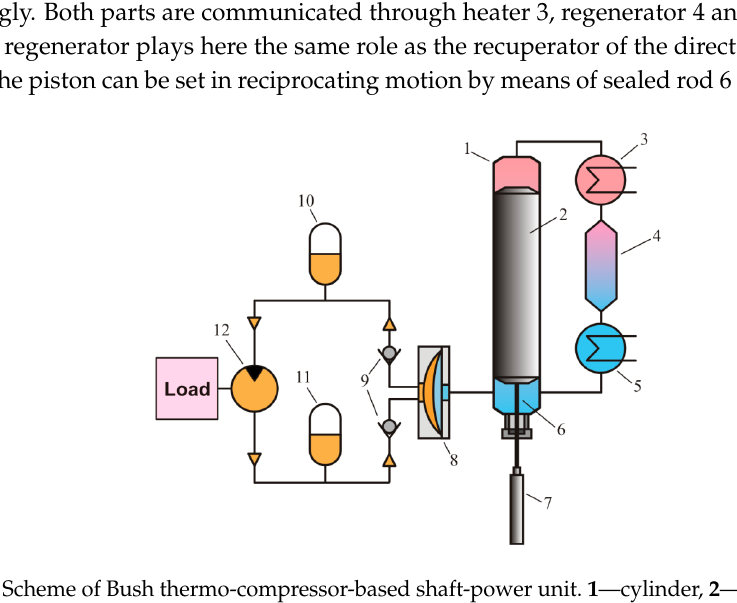
Figure 3. Scheme of Bush thermo-compressor-based shaft-power unit. 1 —cylinder, 2 —piston, 3 —heater, 4 —regenerator, 5 —cooler, 6 —connecting rod, 7 —linear actuator, 8 —diaphragm unit, 9 —non-return valves, 10 —high-pressure accumulator, 11 —low-pressure accumulator, 12 —hydraulic motor.